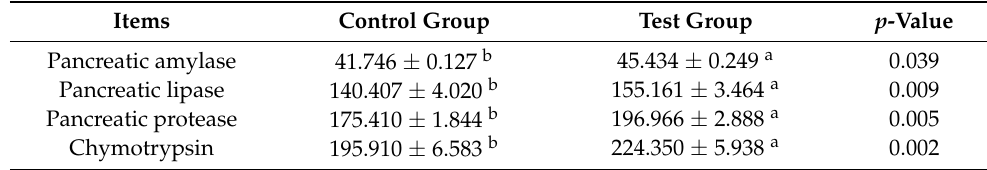
Table 7. Effect of Supplemental Concentrate on Main Digestive Enzyme Activities in Pancreas of Yak Calves (Unit: